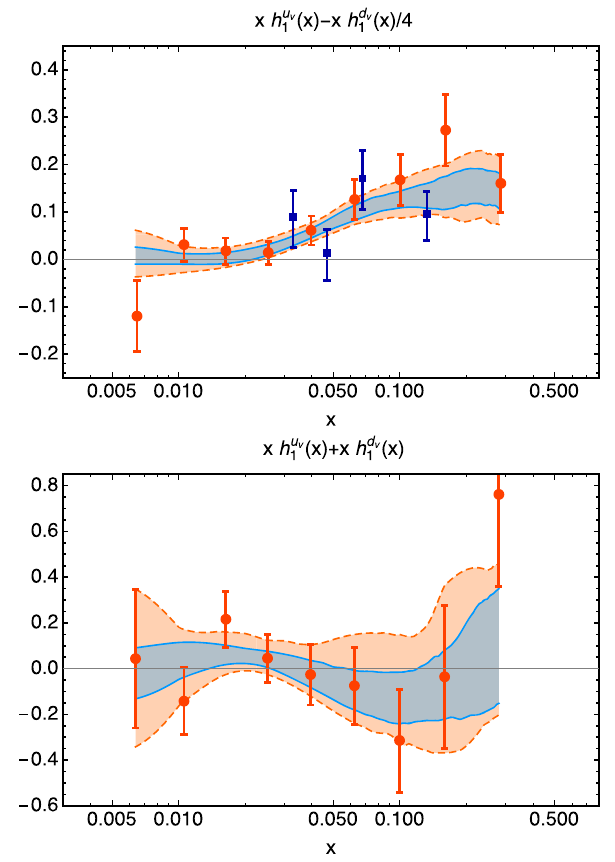
Fig. 6 Combinations of transversities for the proton (upper) and the deuteron (lower) compared to the global 68% in blue (with full blue line contour) and 95% in orange (with dashed contours) for the present fit compared to the extracted data [8]. The dark blue square come from HERMES data while the dark orange dots are extracted from COM- PASS data (cid:15) w ) × N + N − ( n κ + n κ ) . freedom here is ( j d c j u d